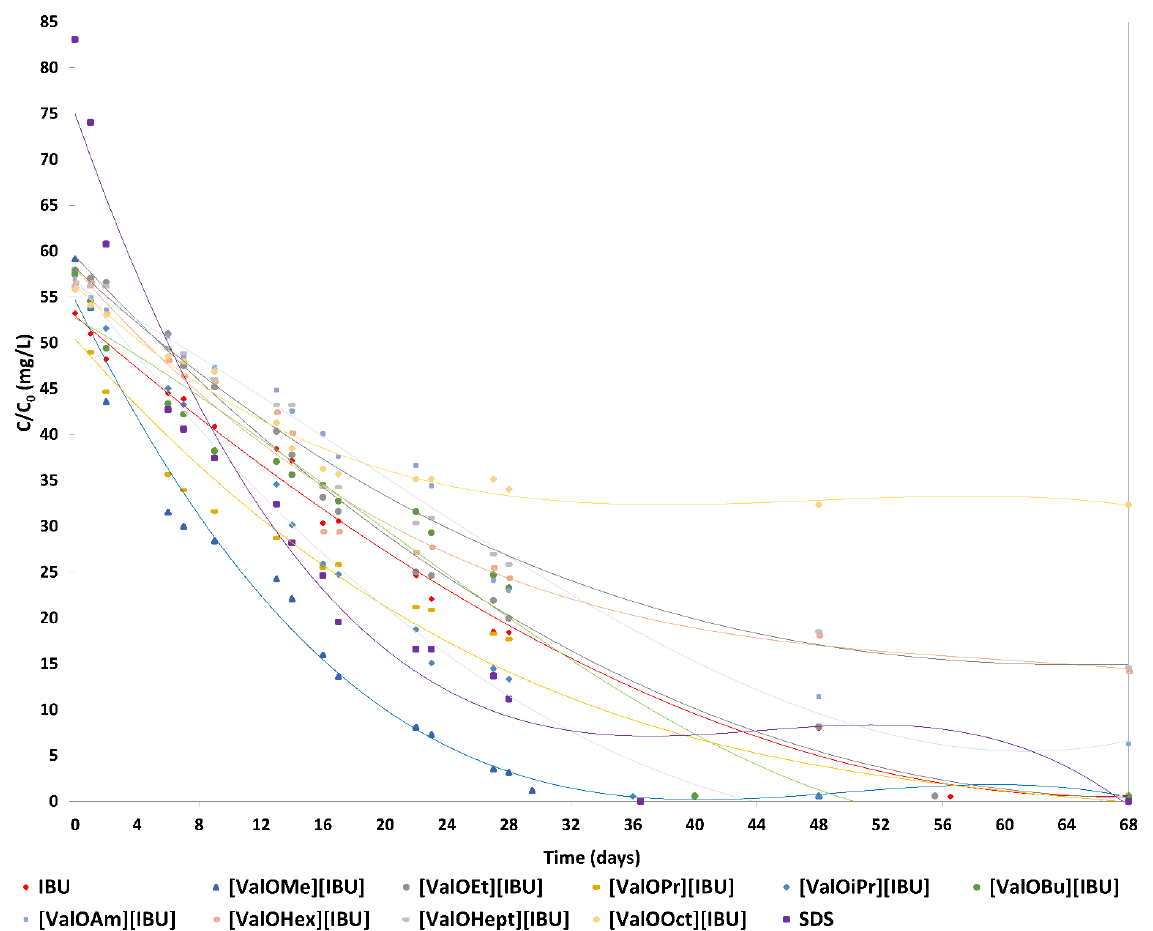
Figure 5. Degradation profiles of ibuprofen, the alkyl esters of L-valine, and SDS by bacterial cultures. Experimental conditions: IBU= 53.24 mg/L, [ValOMe][IBU] = 59.16 mg/L, [ValOEt][IBU] = 58.16 mg/L, [ValOPr][IBU] = 58.00 mg/L, [Va- lOiPr][IBU] = 57.96 mg/L, [ValOBu][IBU] = 57.44 mg/L, [ValOAm][IBU] = 57.00 mg/L, [ValOHex][IBU] = 56.56 mg/L, [ValO-